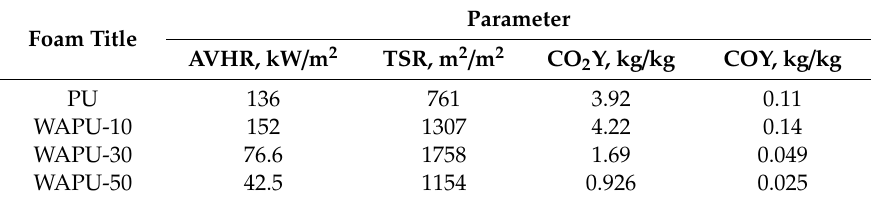
Table 4. Flame retardancy parameters of PU and WAPU foams.